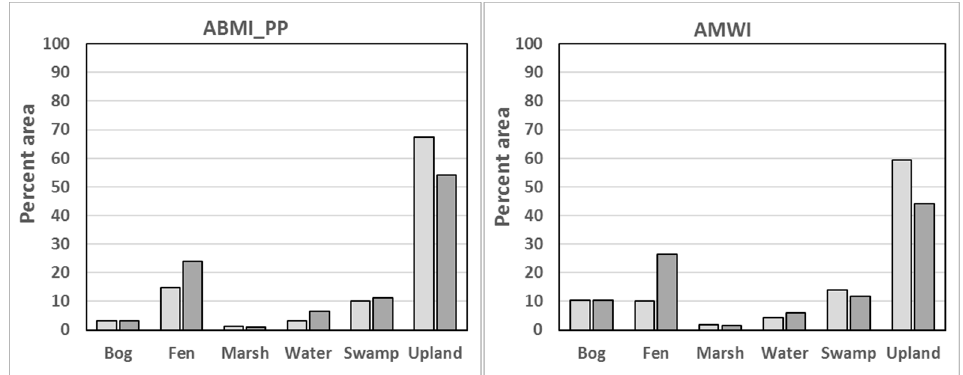
Figure 2. Class distributions within the training (west) and test regions (east) of the study area for the AMWI and ABMI_PP data sources.